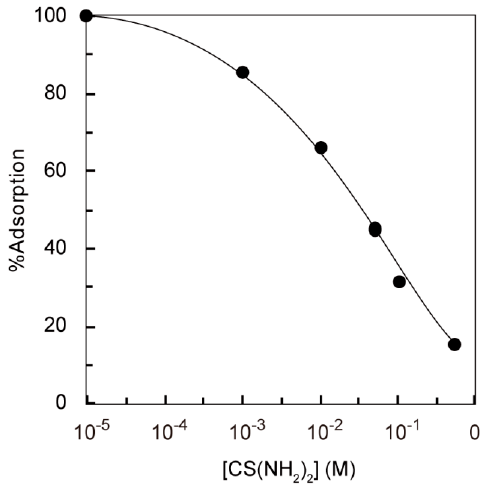
Figure 4. Effect of thiourea concentration on the adsorption of Ag(I) on the DTO-MAR for Ag(I). Conditions: Ag(I) concentration = 0.2 mM, weight of adsorbent = 10 mg, H 2 SO 4 concentration = 0.05 M, volume of test solution = 10 mL, temperature = 30 °C, and shaking time = 24 h.